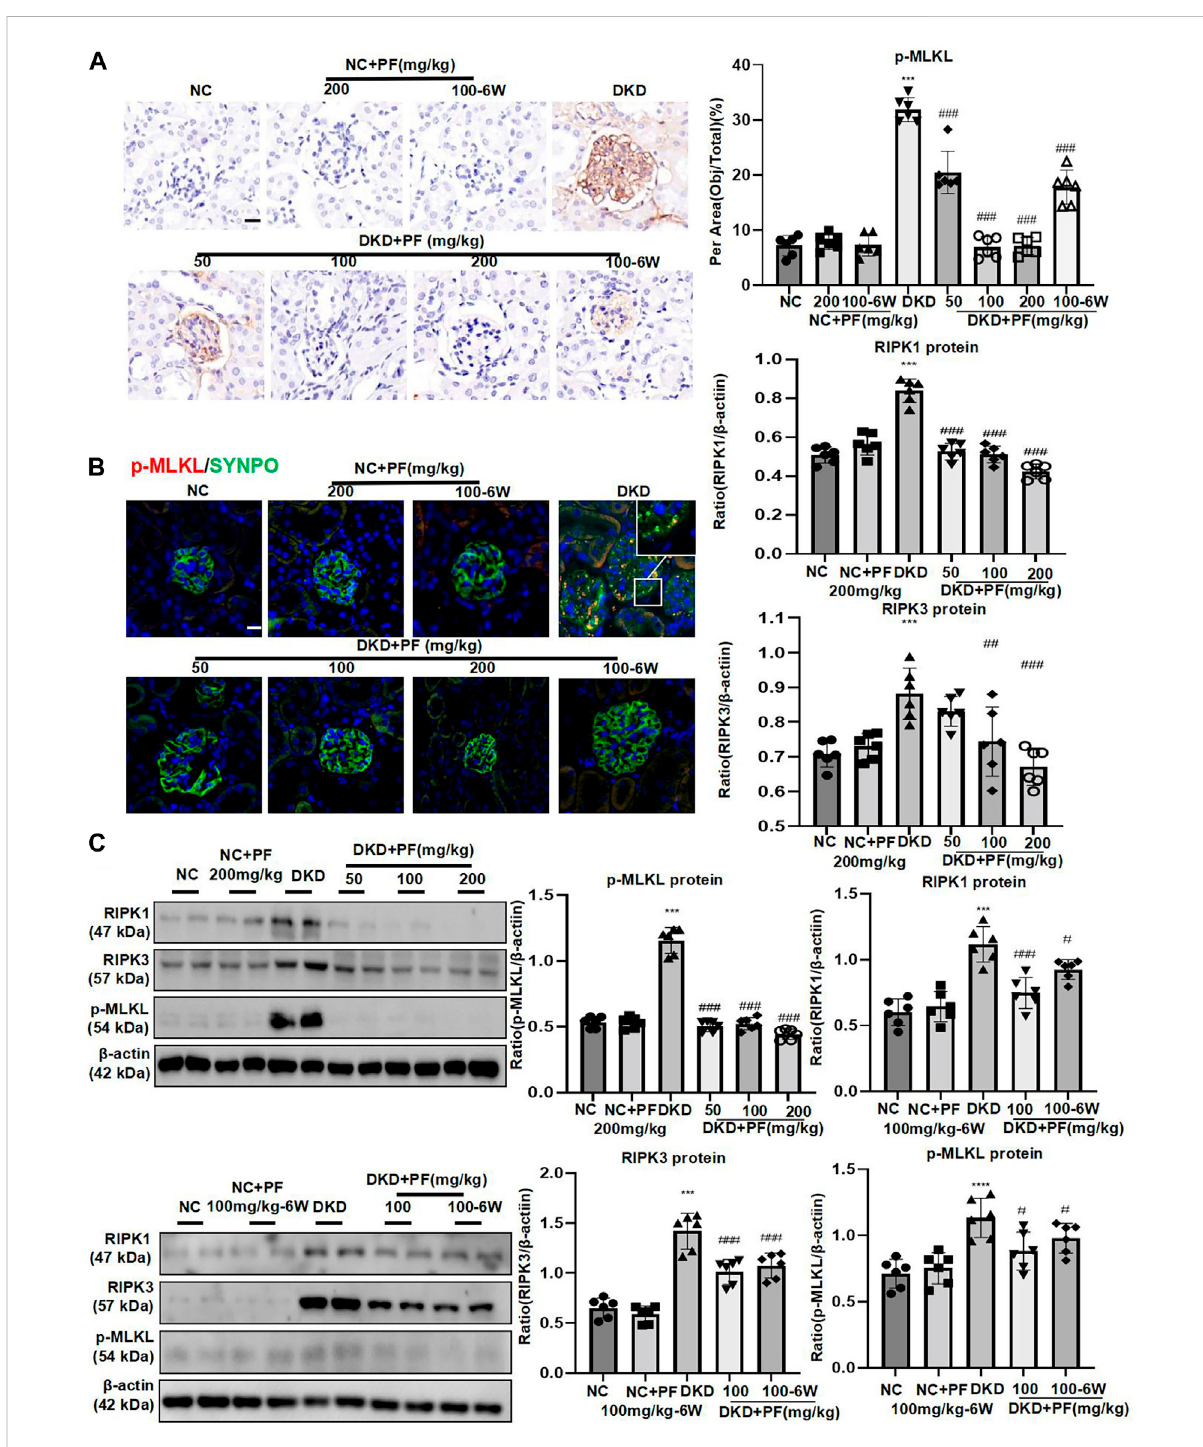
FIGURE 6 PF regulates podocyte necroptosis in STZ-induced diabetic mice. (A) IHC assay of p-MLKL protein expression on the glomerulus in STZ- induced diabetic mice. Scale bar = 50 μ m. (B) IF double staining of p-MLKL and SYNPO proteins expression in renal biopsy samples. Scale bar = 50 μ m. (C) WB assay of RIPK1, RIPK3, and p-MLKL proteins in STZ-induced diabetic mice. Data represent the mean ± SD for 6 mouse/group. *** p < 0.001 vs. NC; # p < 0.05, ## p < 0.01, ### p < 0.001 vs. DKD. NC, normal control; PF, paeoni fl orin; STZ, streptozotocin; DKD, diabetic kidney disease; IHC, immunohistochemistry; IF, immuno fl uorescence; WB, Western blotting; SYNPO, synaptopodin; RIPK1, receptor-interacting serine/ threonine kinase 1; RIPK3, receptor-interacting serine/threonine kinase 3; MLKL, mixed-lineage kinase domain-like